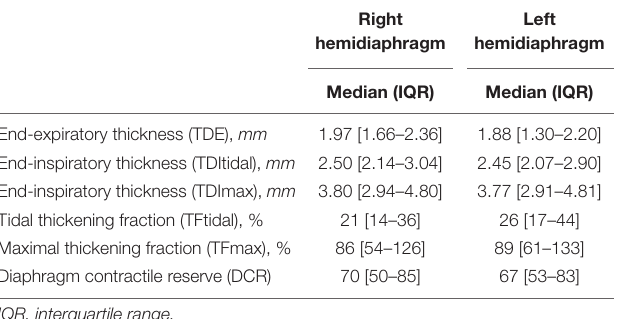
TABLE 2 | Distribution of diaphragm ultrasound variables.